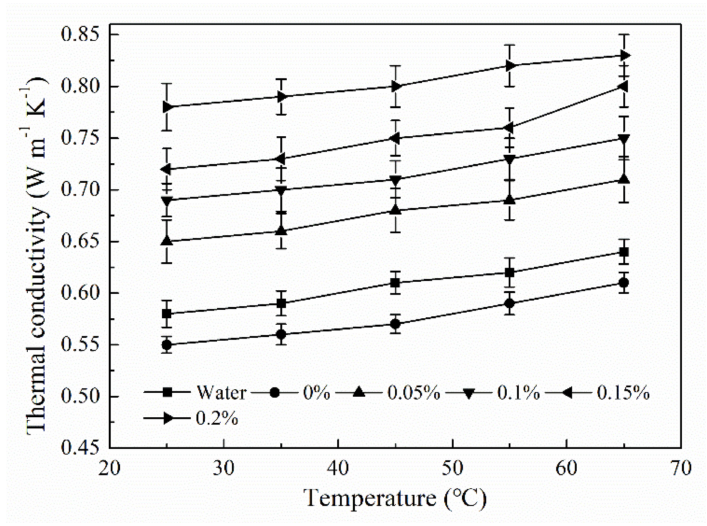
Figure 8. Thermal conductivity curves of water and hybrid suspension with di ff erent CNT concentrations varying with